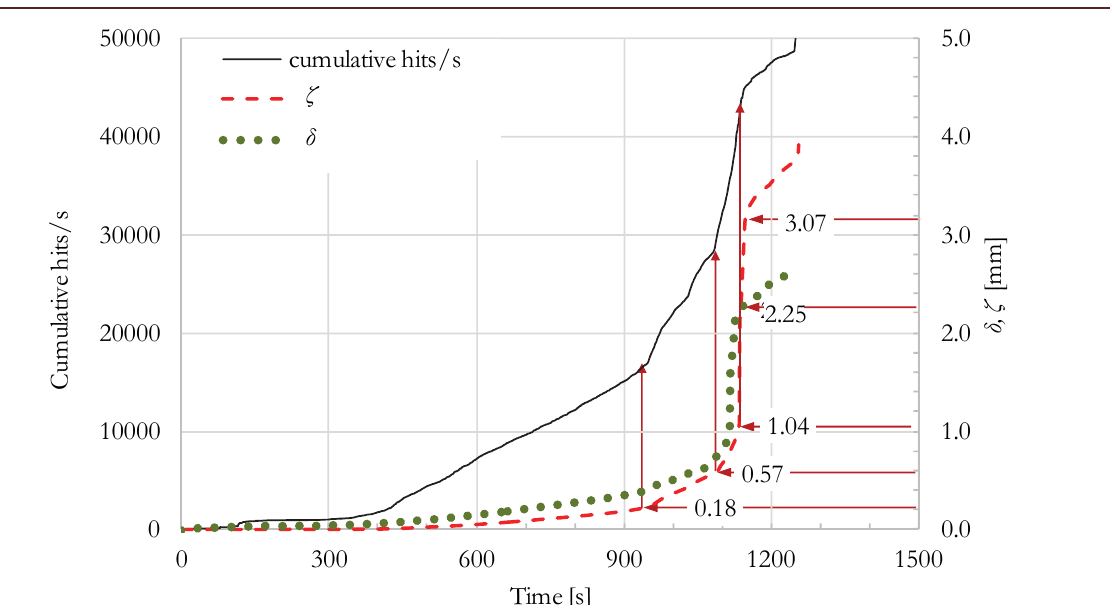
Figure 8: The time dependence of the cumulative hits per second in conjunction to that of the deflection and the opening of the fault.